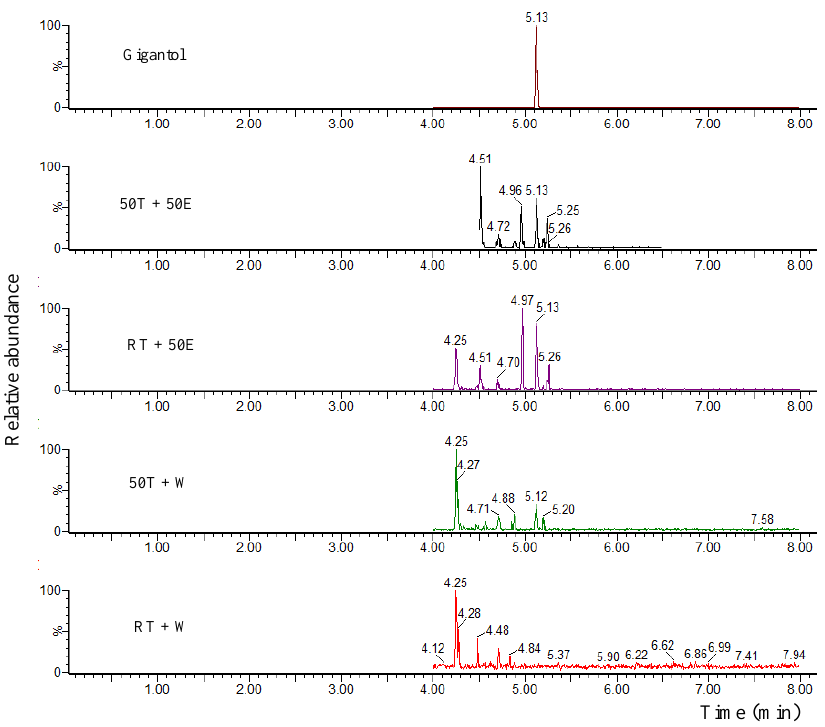
Figure 1. LC/MS/MS chromatograms of gigantol in the four extracts.